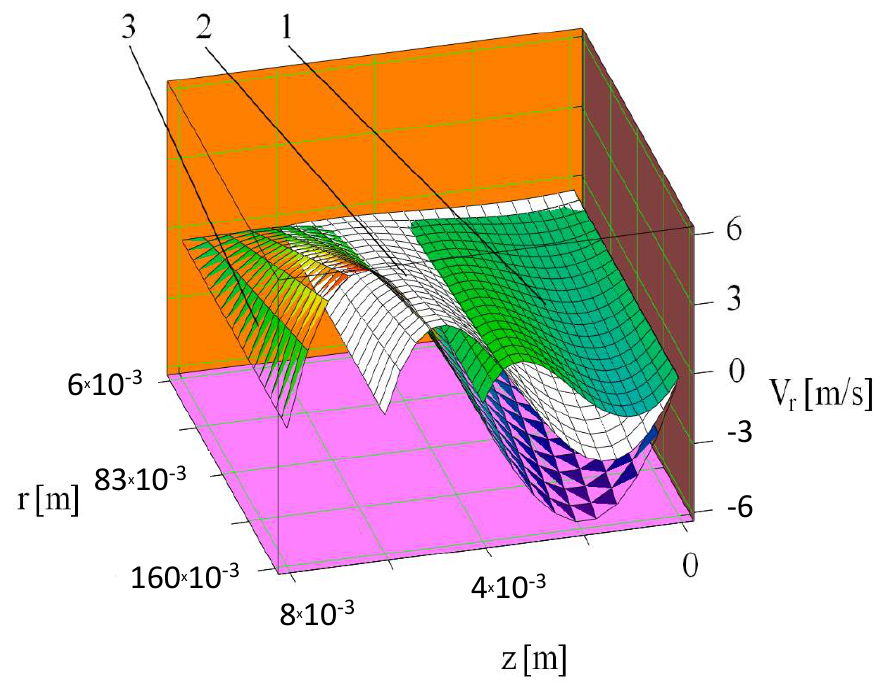
Figure 5. Graphs of the radial velocity component for different values of disk gap heights: 1– h = 4·× 10 –3 m; 2– h = 6·× 10 –3 m; 3– h = 8·× 10 –3 m. The dependences show that the maximum value of the radial velocity component corresponds to the disk gap height h = (5/7) × 10 –3 m. Figure 6 presents the analytical graphs of the radial velocity component for different values of angular velocity ω and disk gap height h = 5 × 10 –3 m, with the values of the parameters being in compliance with Figure 5.